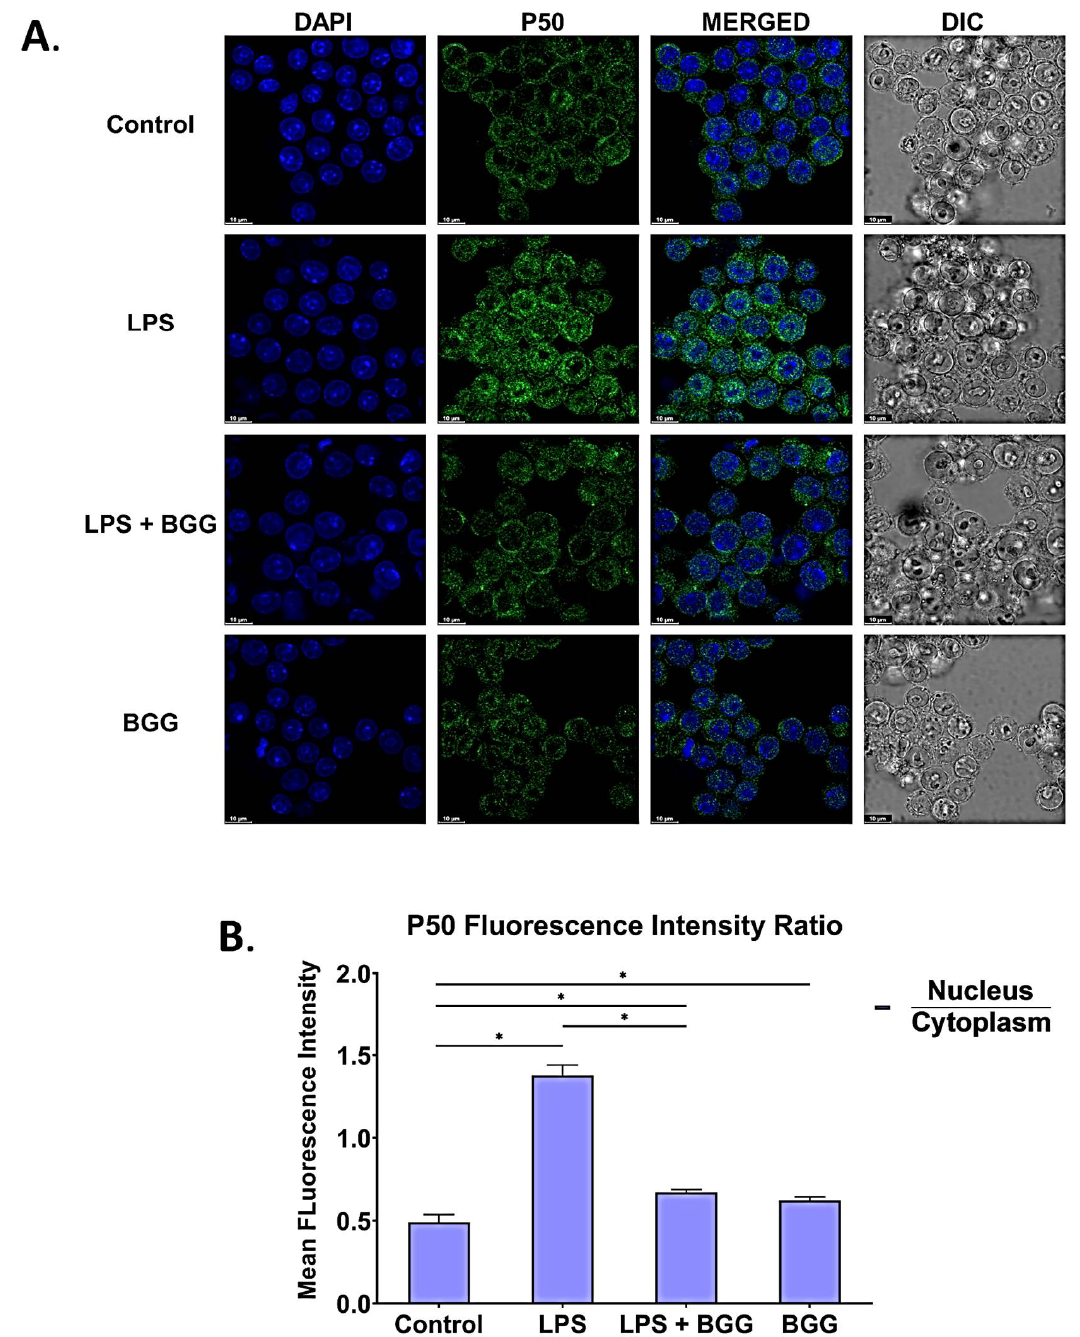
Figure 11. Immunofluorescence staining images representing the BGG attenuation of the LPS-enhanced translocation of p50 from the cytosol to the nucleus measured by confocal microscopy. ( A ) The translocation assay of p50 in RAW 264.7 macrophages. ( B ) The mean fluorescence intensity showing the p50 ratio of nucleus vs. cytoplasm. Results are mentioned as mean ± SEM ( n = 3 independent experiments) (* p ≤ 0.05). Scale bars: 10 μm.